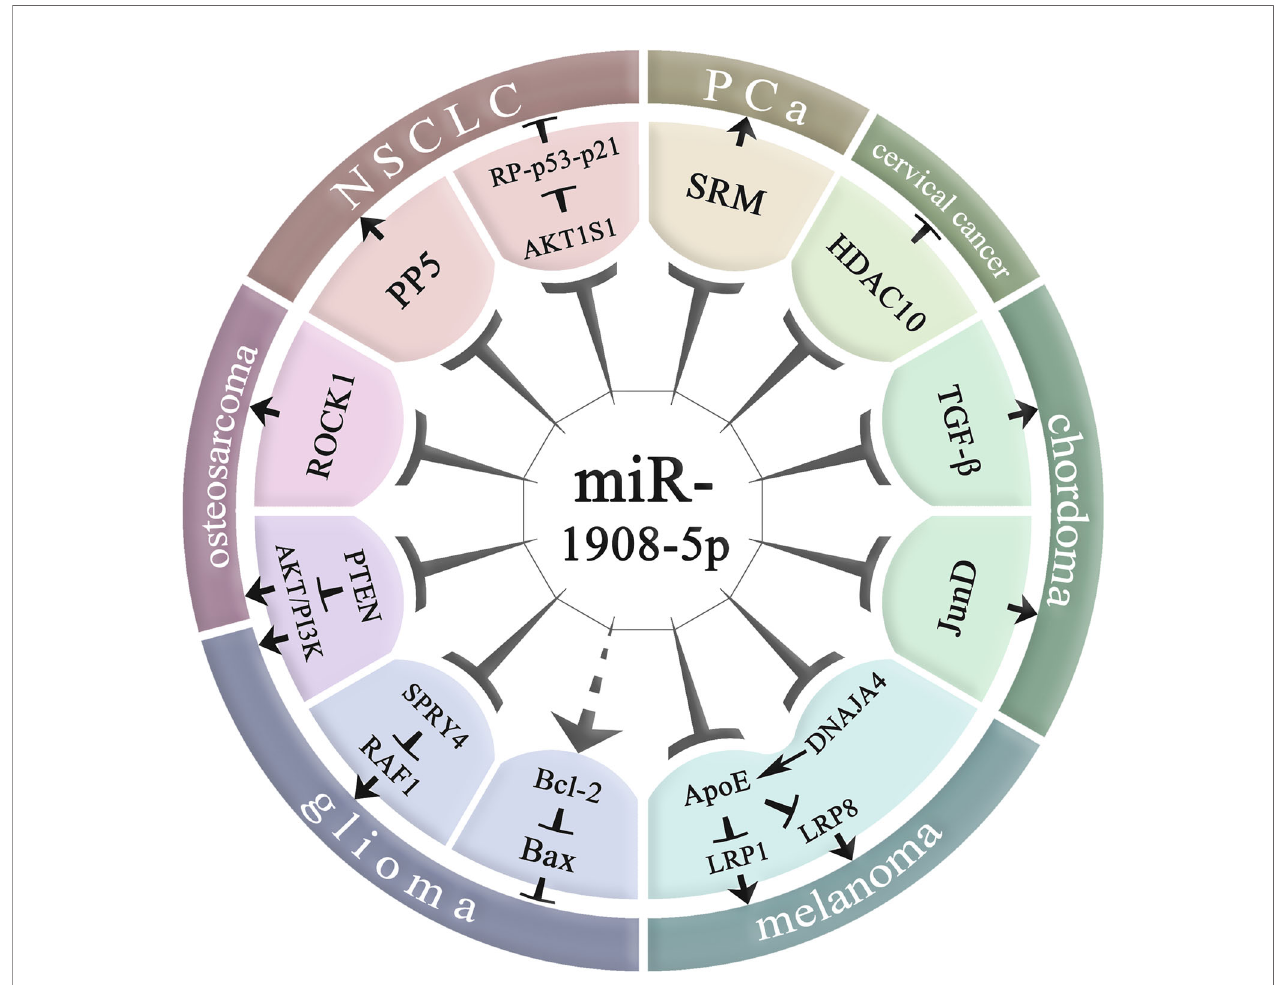
FIGURE 4 | Molecular regulatory mechanisms of miR-1908-5p in cancer. NSCLC, non-small cell lung cancer; PCa, prostate cancer; miR-1908-5p plays an important role in various cancers by regulating downstream gene